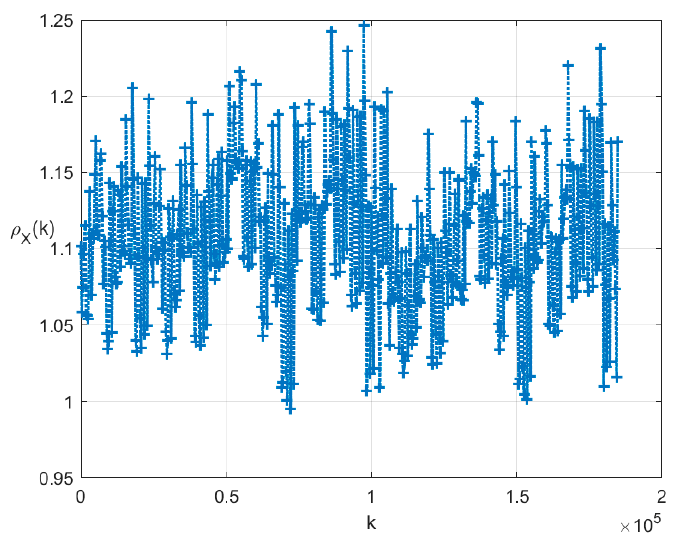
Figure 5. Indicators for k ∈ [ 1,184786 ]